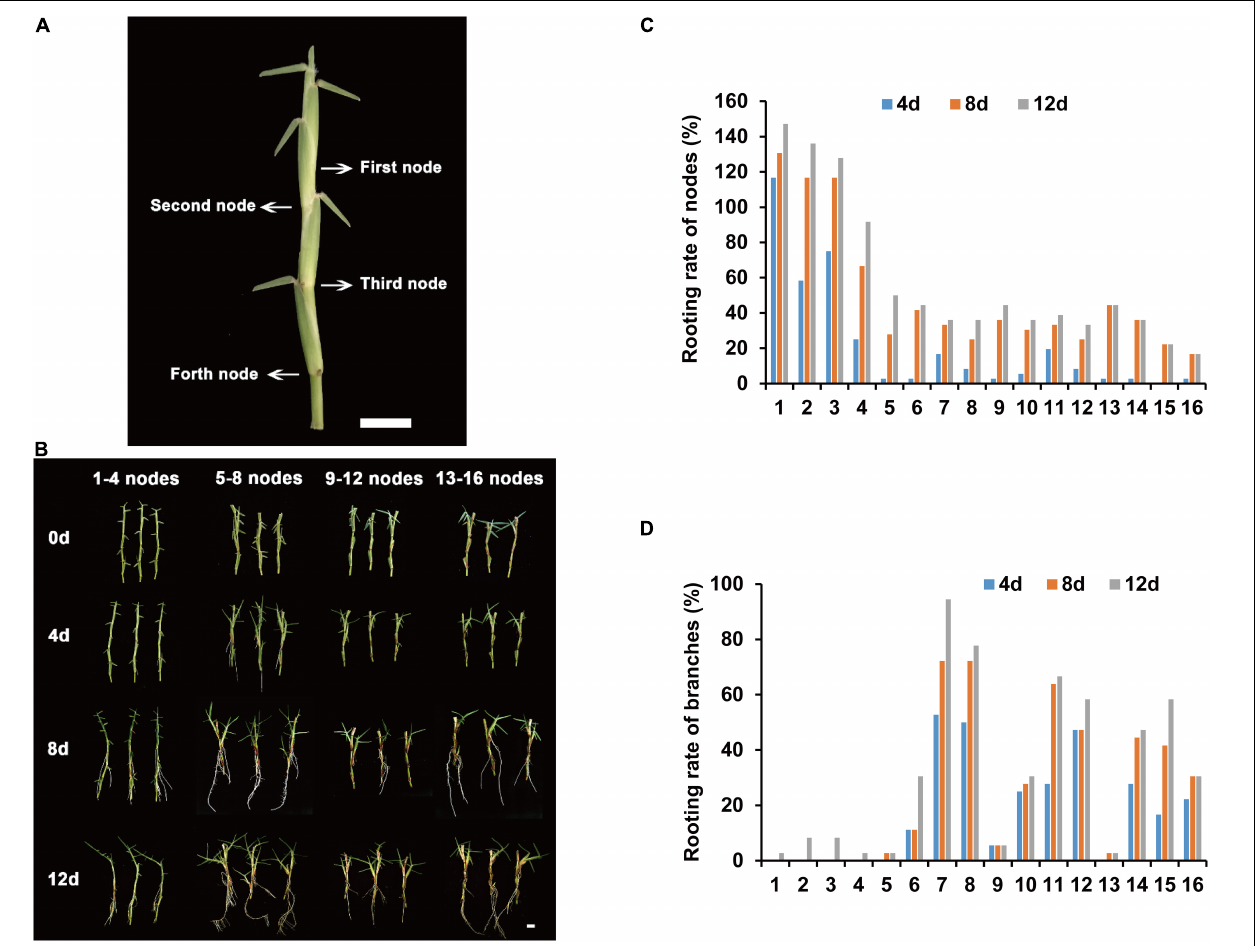
FIGURE 1 | Rooting ability evaluation of different accessions and nodes. (A) The nodes order of centipedegrass. Scale bar represents 1 cm. (B) The rooting situation of nodes 1–16 of E039 after water culture at 0, 4, 8, and 12 days. (C) The rooting rate of 1–16 nodes after water culture at 4, 8, and 12 days. (D) The rooting rate of branches of nodes 1–16 after water culture at 4, 8, and 12